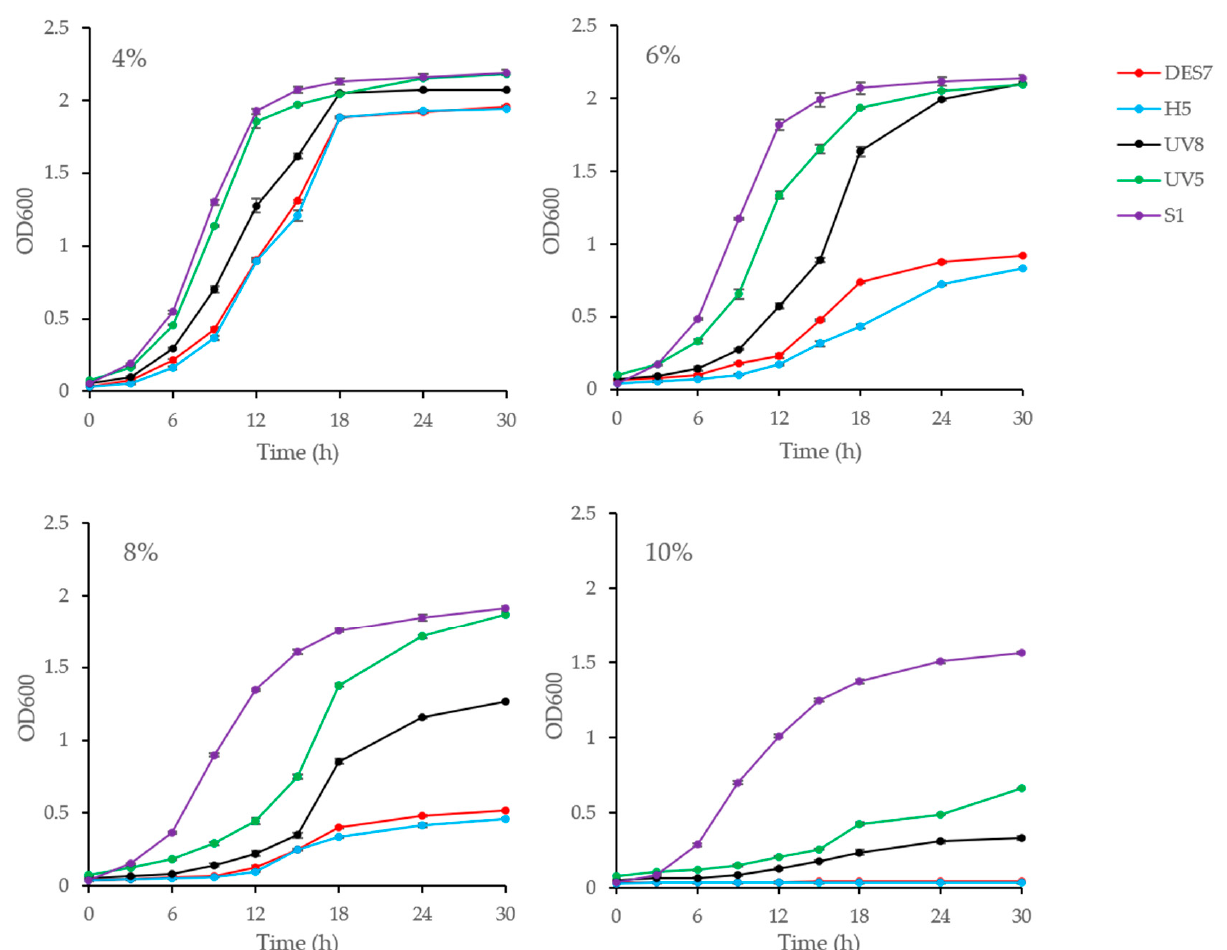
Figure 3. The growth curves of the mutants at ethanol concentrations of 4%, 6%, 8%, and 10% ( v / v ). Strain H5 and S1 served as controls at various ethanol concentrations.